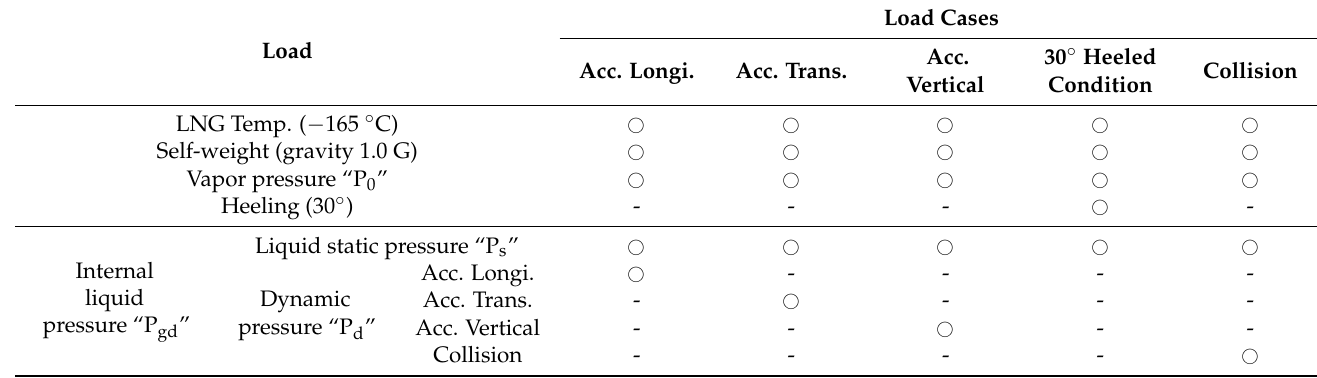
Figure 5. Load and boundary condition for target FE model. Table 3. Load cases for structural analysis.